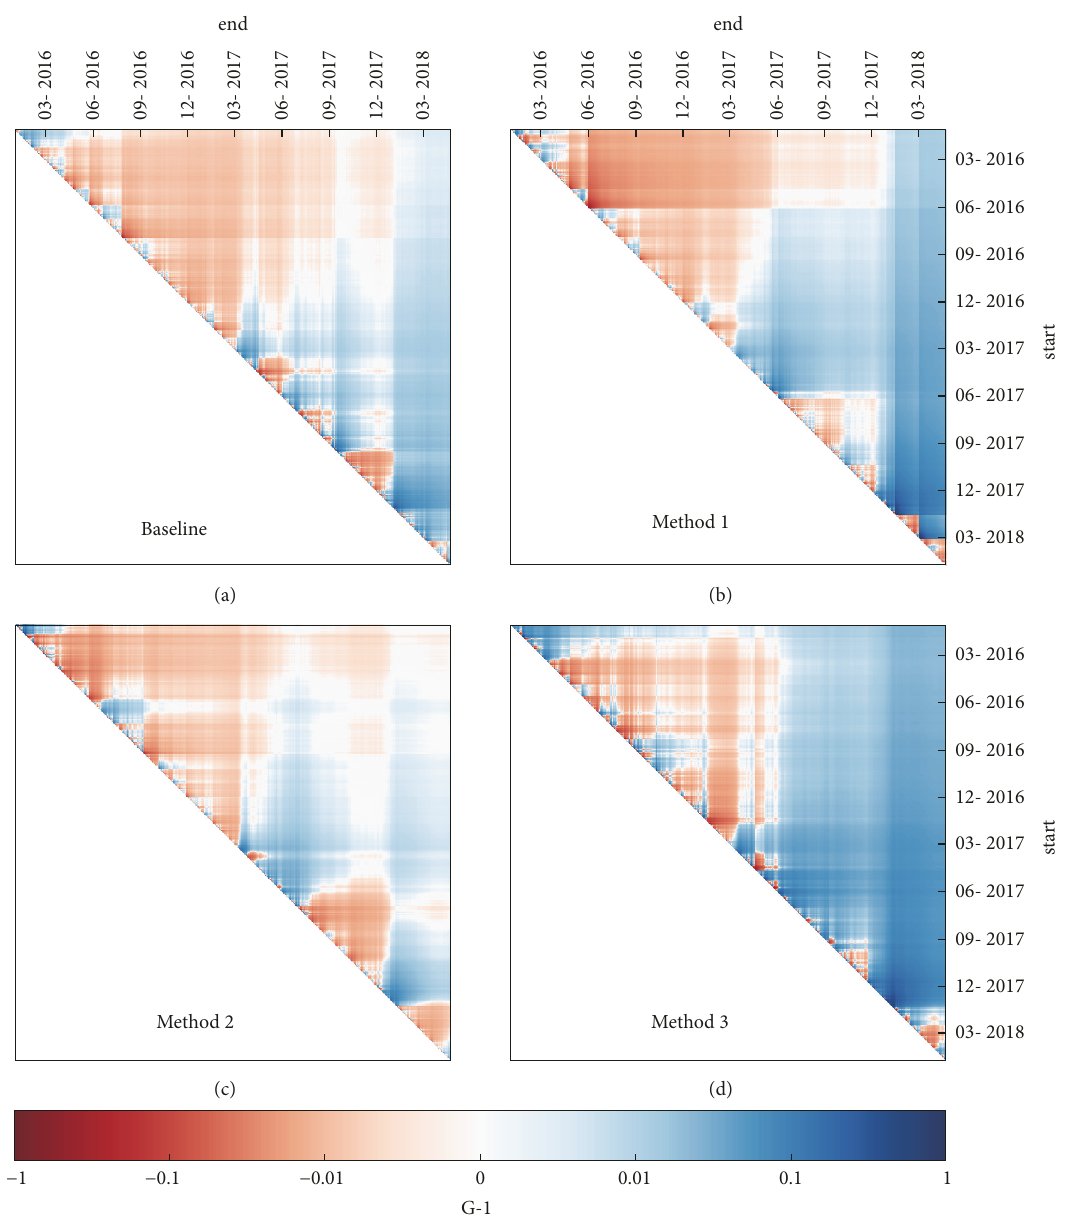
Figure 17: Geometric mean return obtained within different periods of time. The geometric mean return computed between time “start” and “end” using the Sharpe ratio optimisation for the baseline (a), Method 1 (b), Method 2 (c), and Method 3 (d). Note that, for visualization purposes, the figure shows the translated geometric mean return G-1. Shades of red refer to negative returns and shades of blue to positive ones (see colour